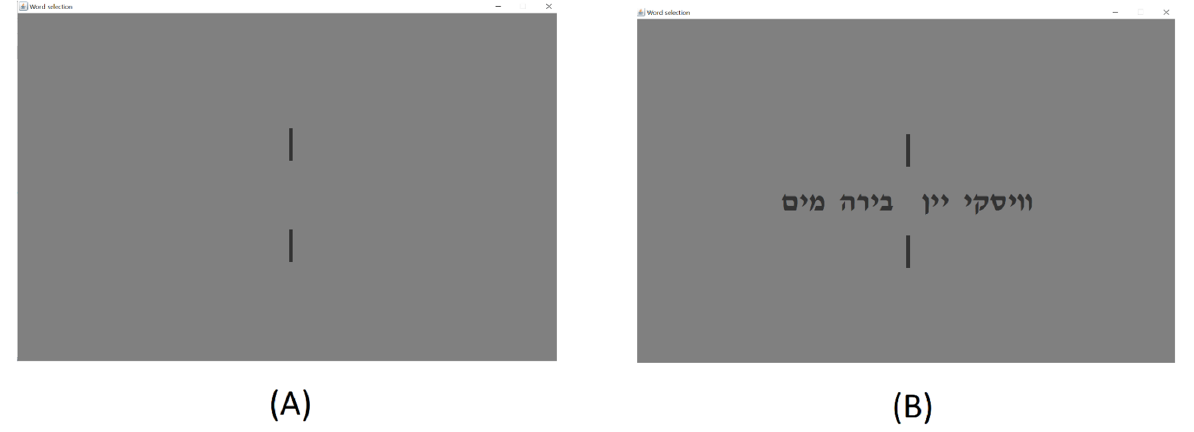
Figure 1. ( A ) Standby screen. ( B ) Game board #1 {“Water”, “Beer”, “Wine”, “Whisky”}.